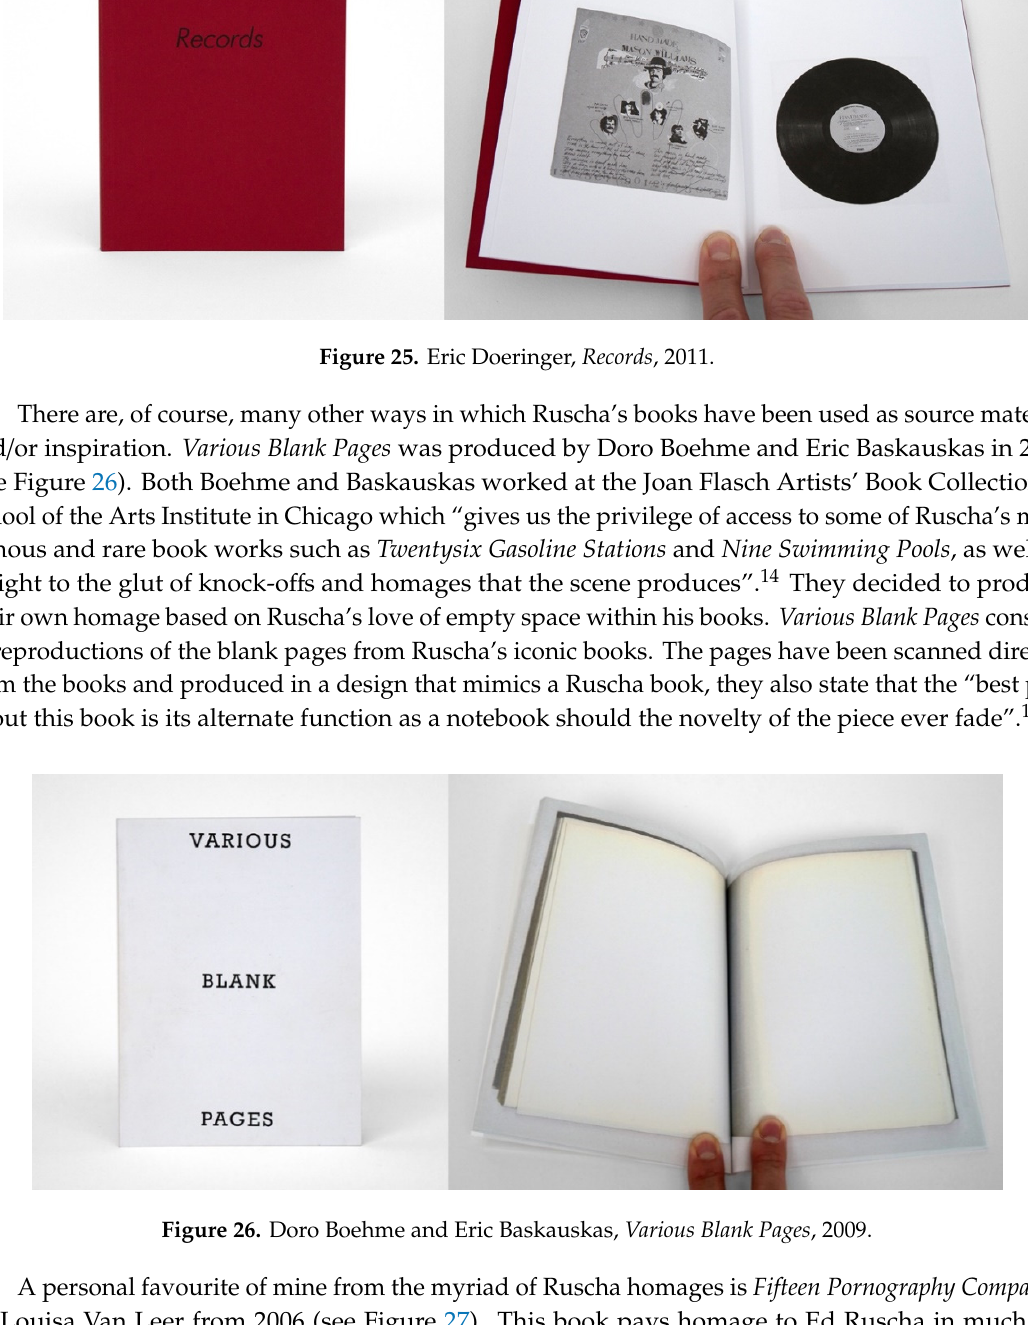
Figure 24. Eric Doeringer, Real Estate Opportunities , 2009.